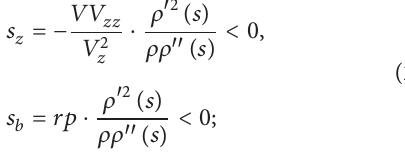
Figure 1: The phase diagram and the effect of a permanent terms- of-trade deterioration for Case 1(a).